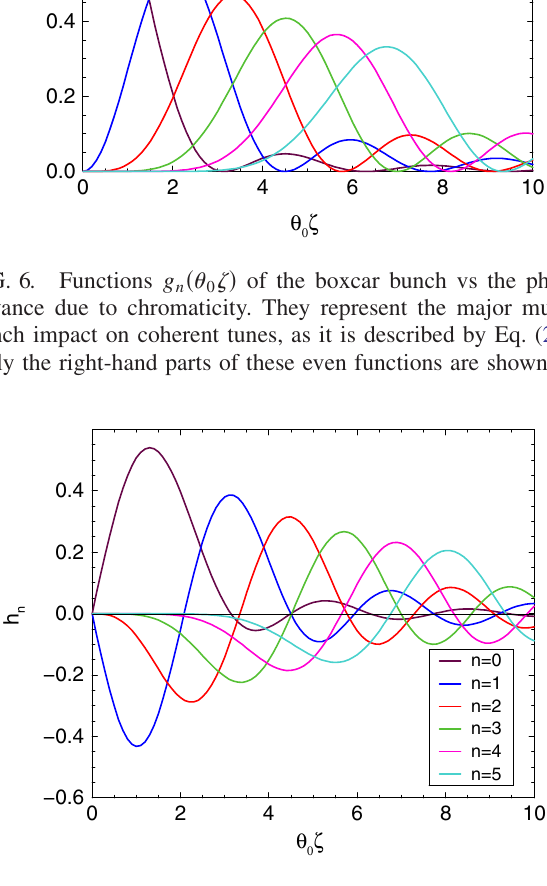
ð (cid:1) 0 (cid:5) Þ of the boxcar bunch against chro- FIG. 7. Functions h n maticity. The curves represent the multibunch effect due to are plotted likewise n variation of the resistive wall wakefield inside a bunch. The right-hand parts of these odd functions are shown.